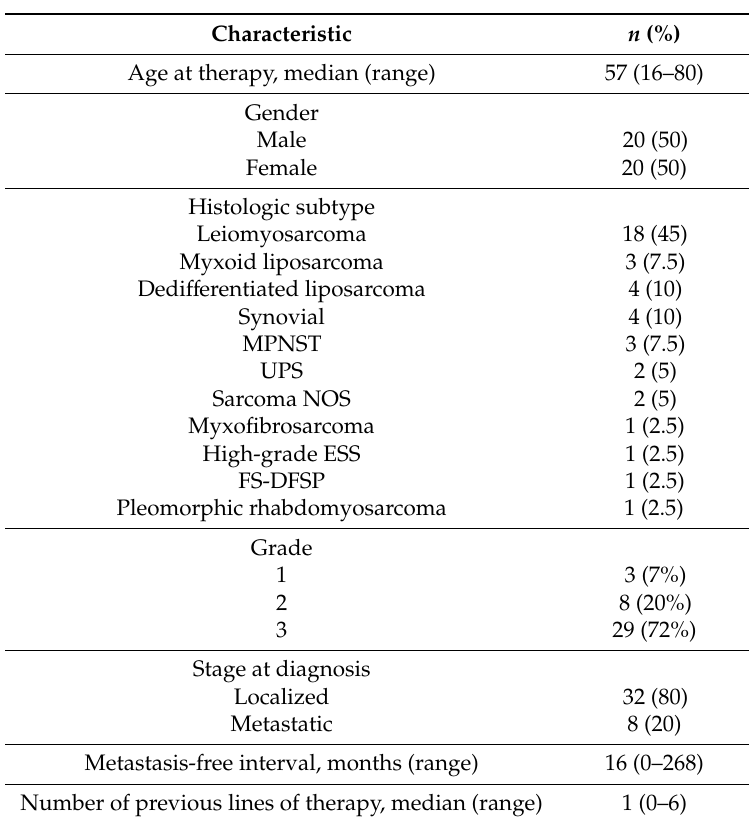
Table 1. Demographics and clinical characteristics of the 40